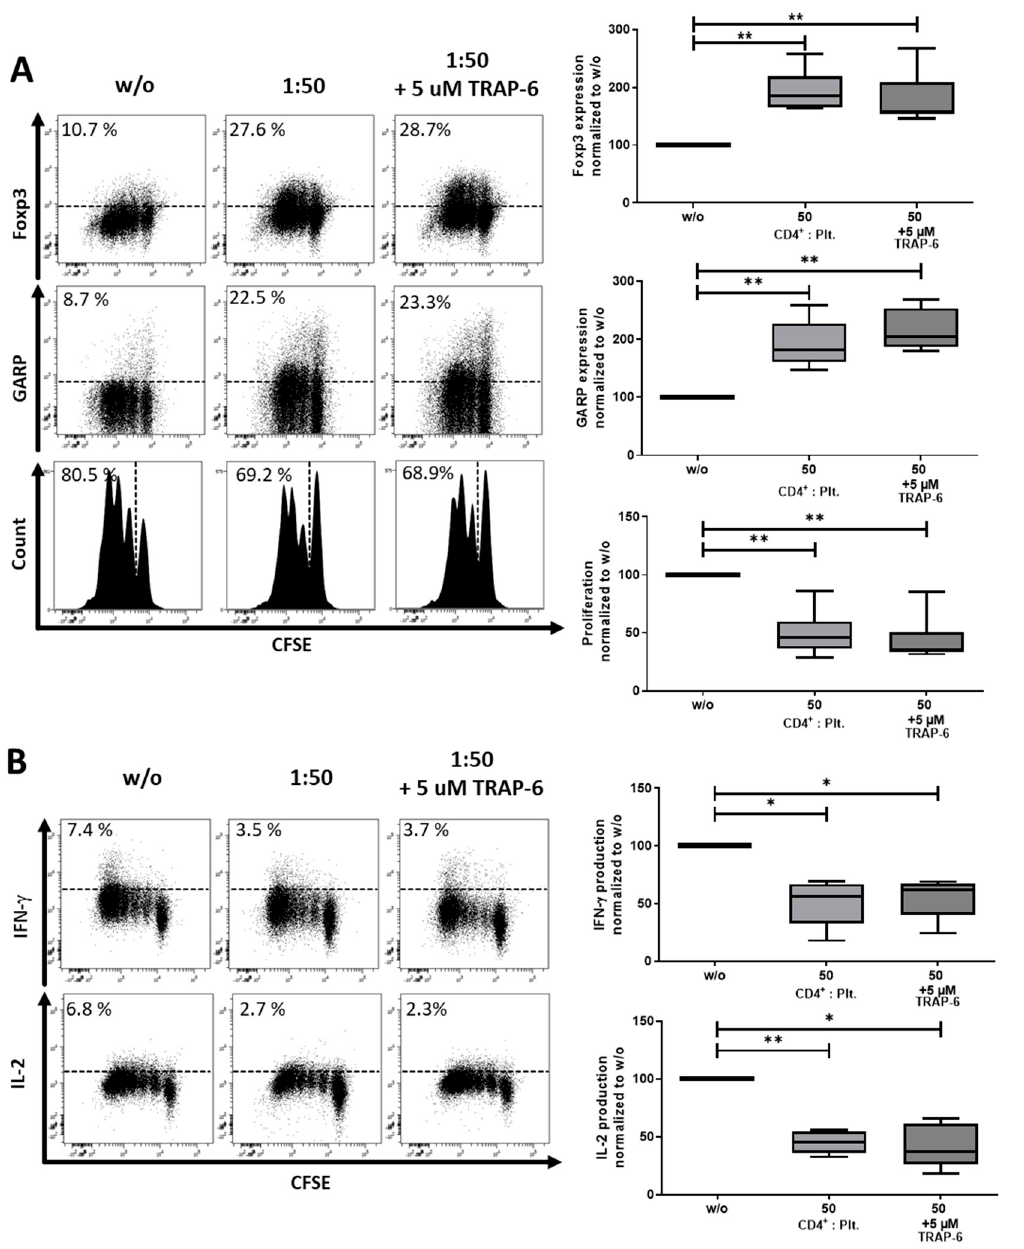
Figure A5. TRAP-6-activated platelets induced a regulatory phenotype in CD4 + CD25 − T cells. 1 × 10 6 CD4 + CD25 − T cells were stimulated with 0.5 µg/mL anti-CD3 mAb and 1.0 µg/mL anti-CD28 mAb with or without 50 × 10 6 platelets for 6 days and treated with or without 5 µM TRAP-6. ( A ) Foxp3 and GARP expression and proliferation were determined at day 3 via flow cytometry. ( B ) Using intracellular flow cytometry, we analyzed cytokine production of IL-2 and IFN- γ on day 6. Dot plots show one representative result of five independent experiments ( n = 5, box and whiskers, medians ± min/max, * p < 0.05, ** p ≤ 0.01, and n.s. determined by one-way ANOVA).